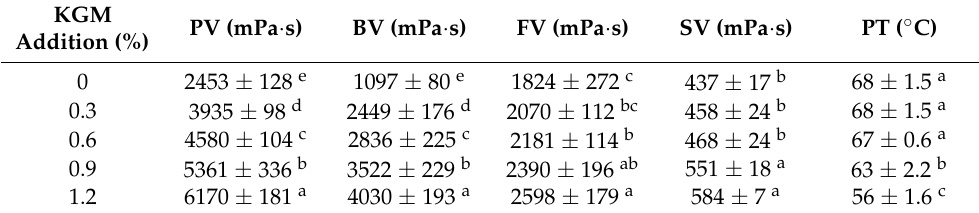
Table 1. Pasting parameters of canna starch (CS)/konjac glucomannan (KGM) mixtures. KGM Addition